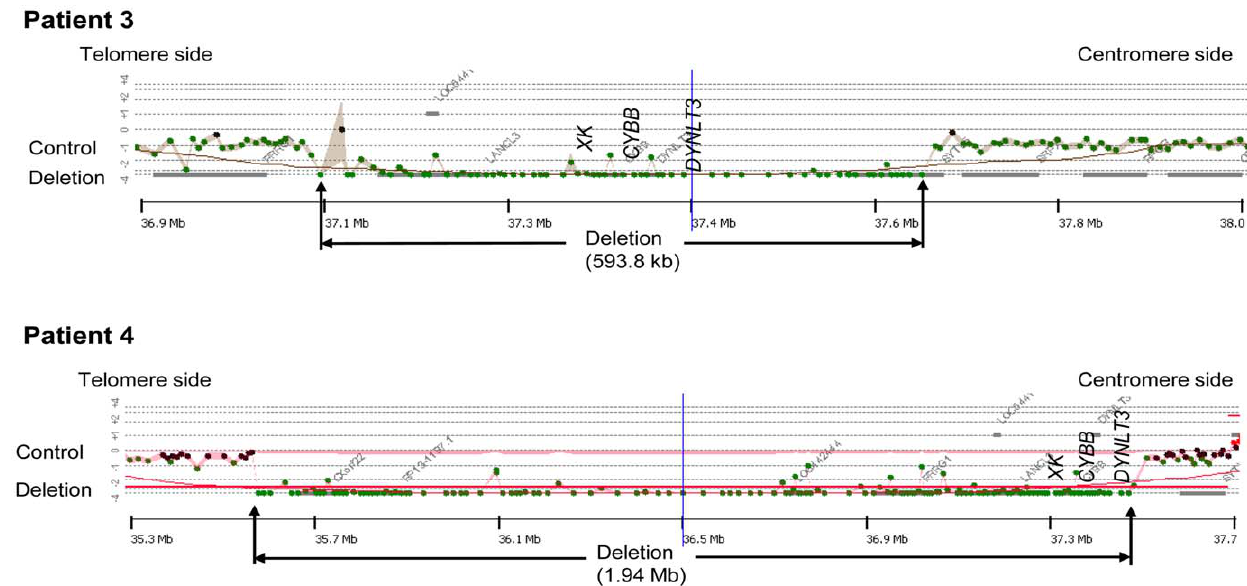
Figure 4. The Results of aCGH Analysis Spanning the Deletion Breakpoints in Patients 3 and 4. A female’s DNA was used for the control DNA for patient 3, and a male’s for patient 4. These male infants suffered deletions of three genes: the chronic granulomatous disease gene ( CYBB ), the McLeod syndrome gene ( XK ), and DYNLT3 . The gene deletions in each patient were found to be 0.59 Mb and 1.94 Mb, respectively.